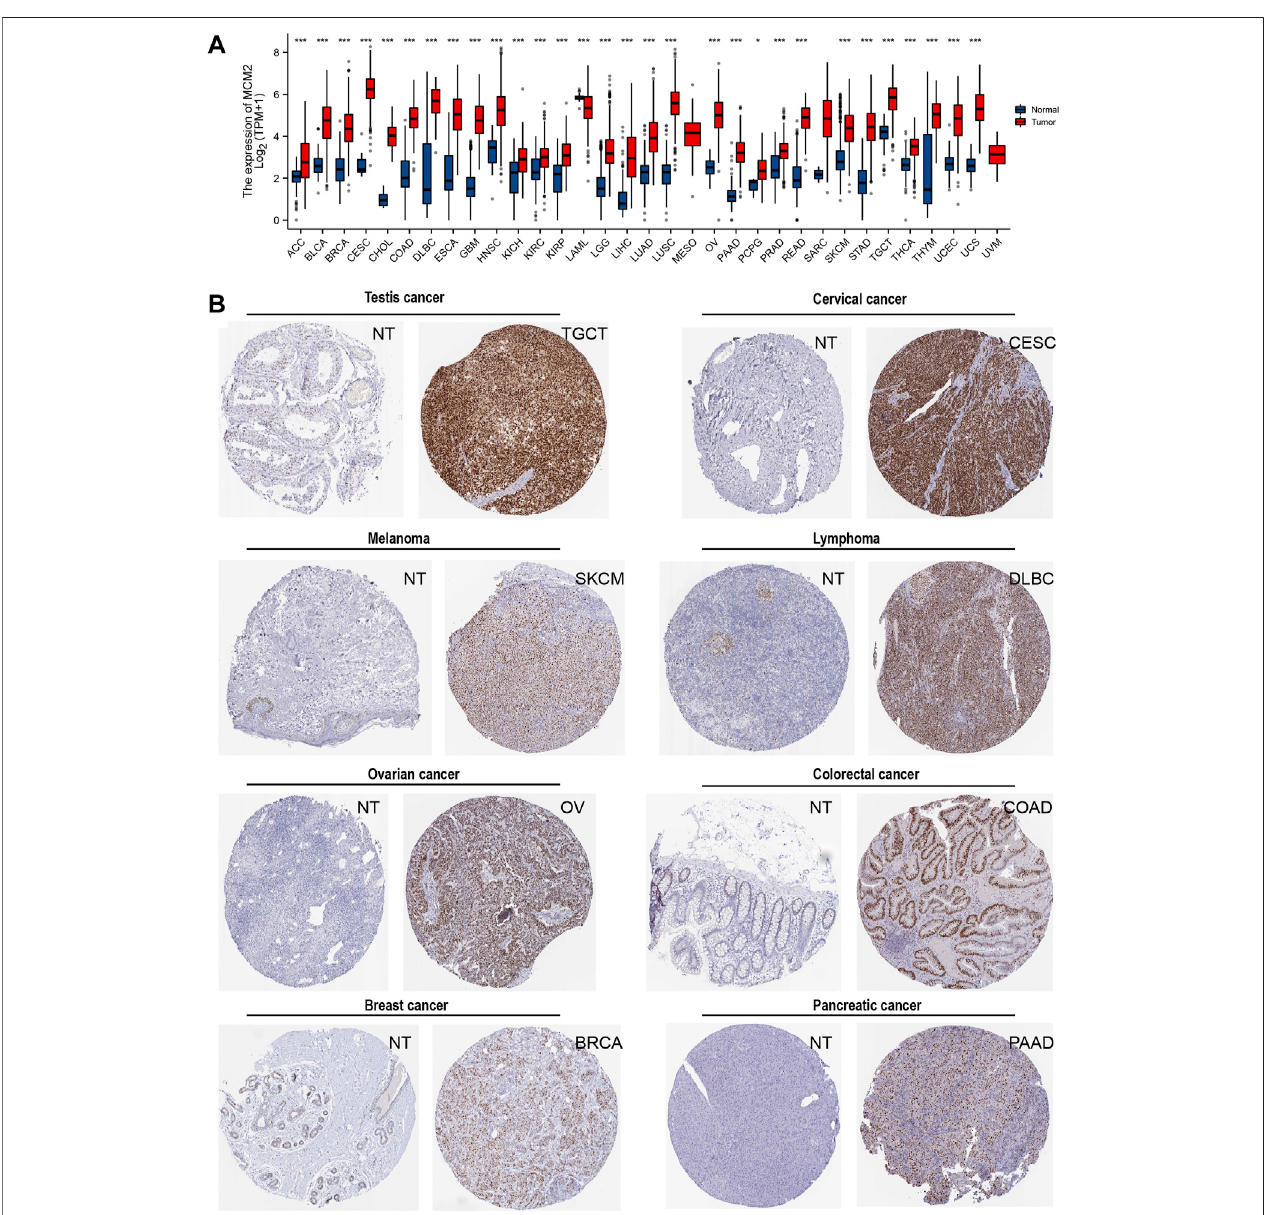
FIGURE 2 | The expression of MCM2 in human cancers. (A) mRNA expression of MCM2 across cancers from TCGA in adrenocortical carcinoma (ACC), bladder urothelial carcinoma (BLCA), breast invasive carcinoma (BRCA), cervical squamous cell carcinoma and endocervical adenocarcinoma (CESC), cholangiocarcinoma (CHOL), colon adenocarcinoma (COAD), lymphoid neoplasm diffuse large B-cell lymphoma (DLBC), esophageal carcinoma (ESCA), glioblastoma multiforme (GBM), head and neck squamous cell carcinoma (HNSC), kidney chromophobe (KICH), kidney renal clear cell carcinoma (KIRC), kidney renal papillary cell carcinoma (KIRP), acute myeloid leukemia (LAML), brain lower-grade glioma (LGG), liver hepatocellular carcinoma (LIHC), lung adenocarcinoma (LUAD), lung squamous cell carcinoma (LUSC), mesothelioma (MESO), ovarian serous cystadenocarcinoma (OV), pancreatic adenocarcinoma (PAAD), pheochromocytoma and paraganglioma (PCPG), prostate adenocarcinoma (PRAD), rectum adenocarcinoma (READ), sarcoma (SARC), skin cutaneous melanoma (SKCM), stomach adenocarcinoma (STAD), testicular germ cell tumors (TGCT), thyroid carcinoma (THCA), thymoma (THYM), uterine corpus endometrial carcinoma (UCEC), uterine carcinosarcoma (UCS), uveal melanoma (UVM). (B) The protein expression of MCM2 in cancers from the HPA database (IHC).